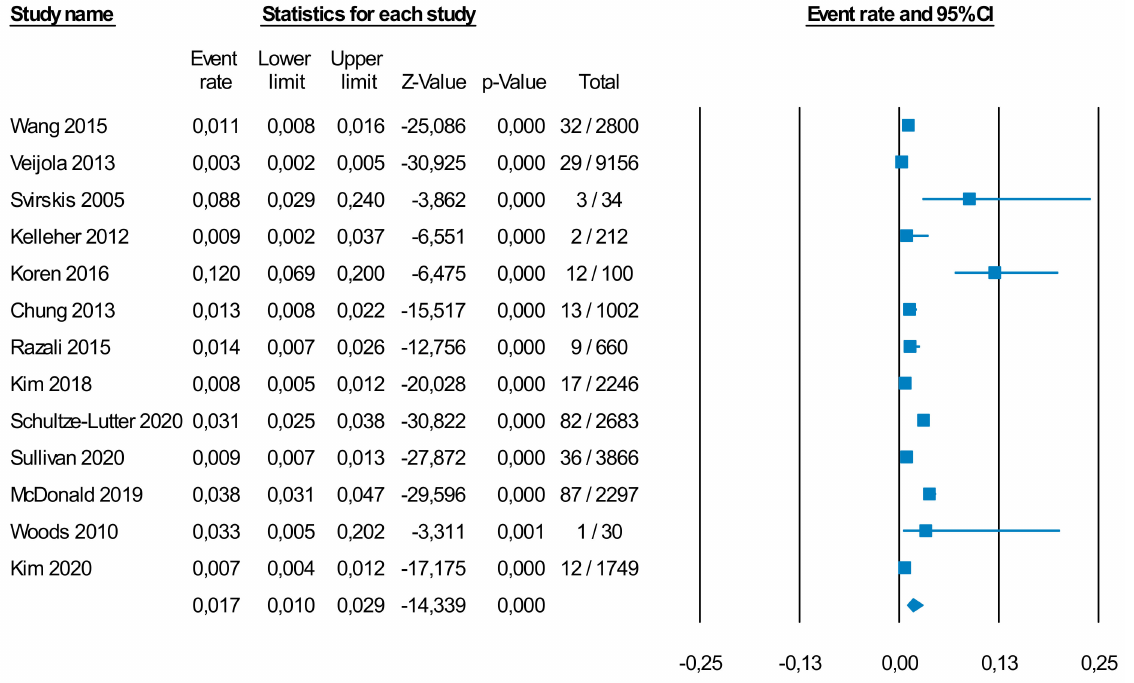
Figure 2. Random effect meta-analysis (forest plot) of the prevalence of CHR-P individuals in the general population. Of the individuals in the general population, 1.7% (95% CI=1.0-2.9%) were found to be at